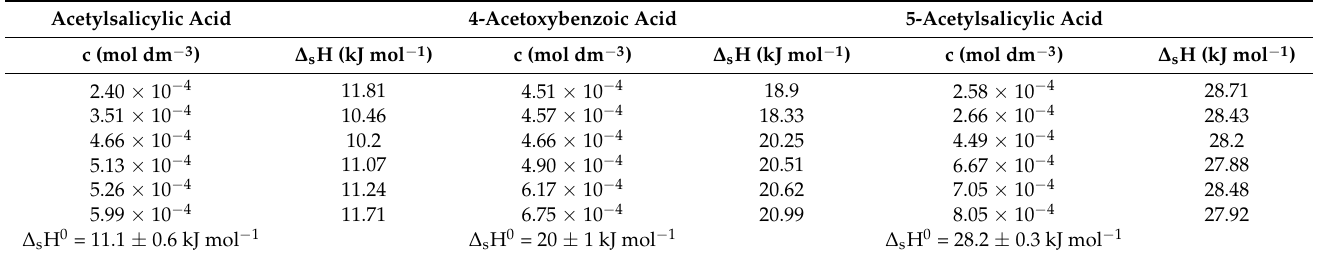
Table 3. Enthalpies of solution of acetylsalicylic acid, 4-acetoxybenzoic acid and 5-acetylsalicylic acid in water at 298.15